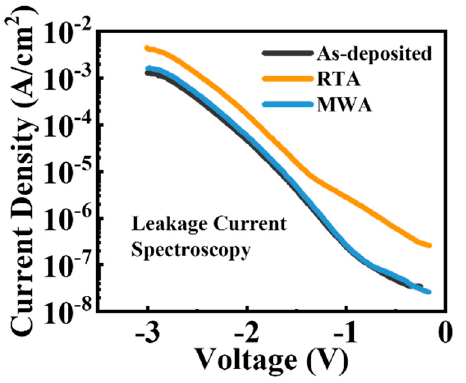
Figure 6. Leakage current density characteristics under different voltages of the as-deposited, RTA, and MWA samples.